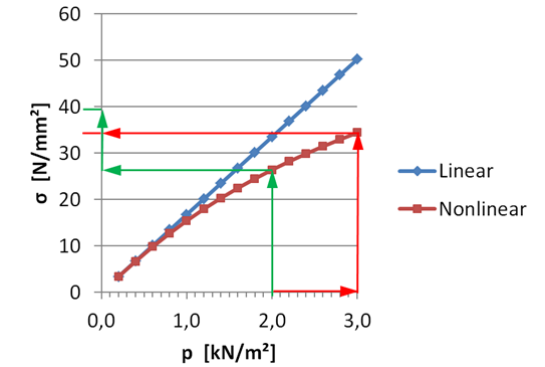
Fig. 1 Comparison of linear and nonlinear